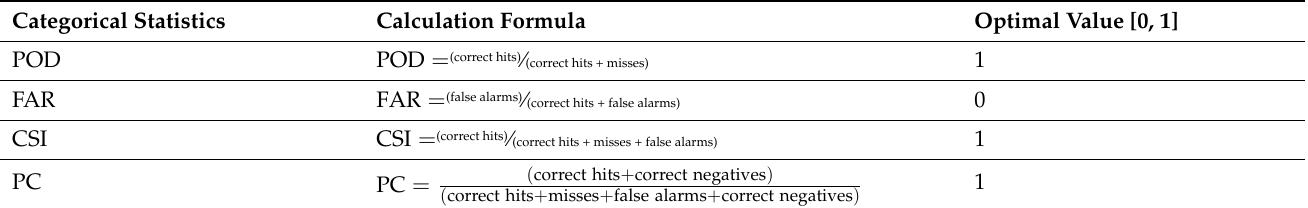
Table 5. Categorical